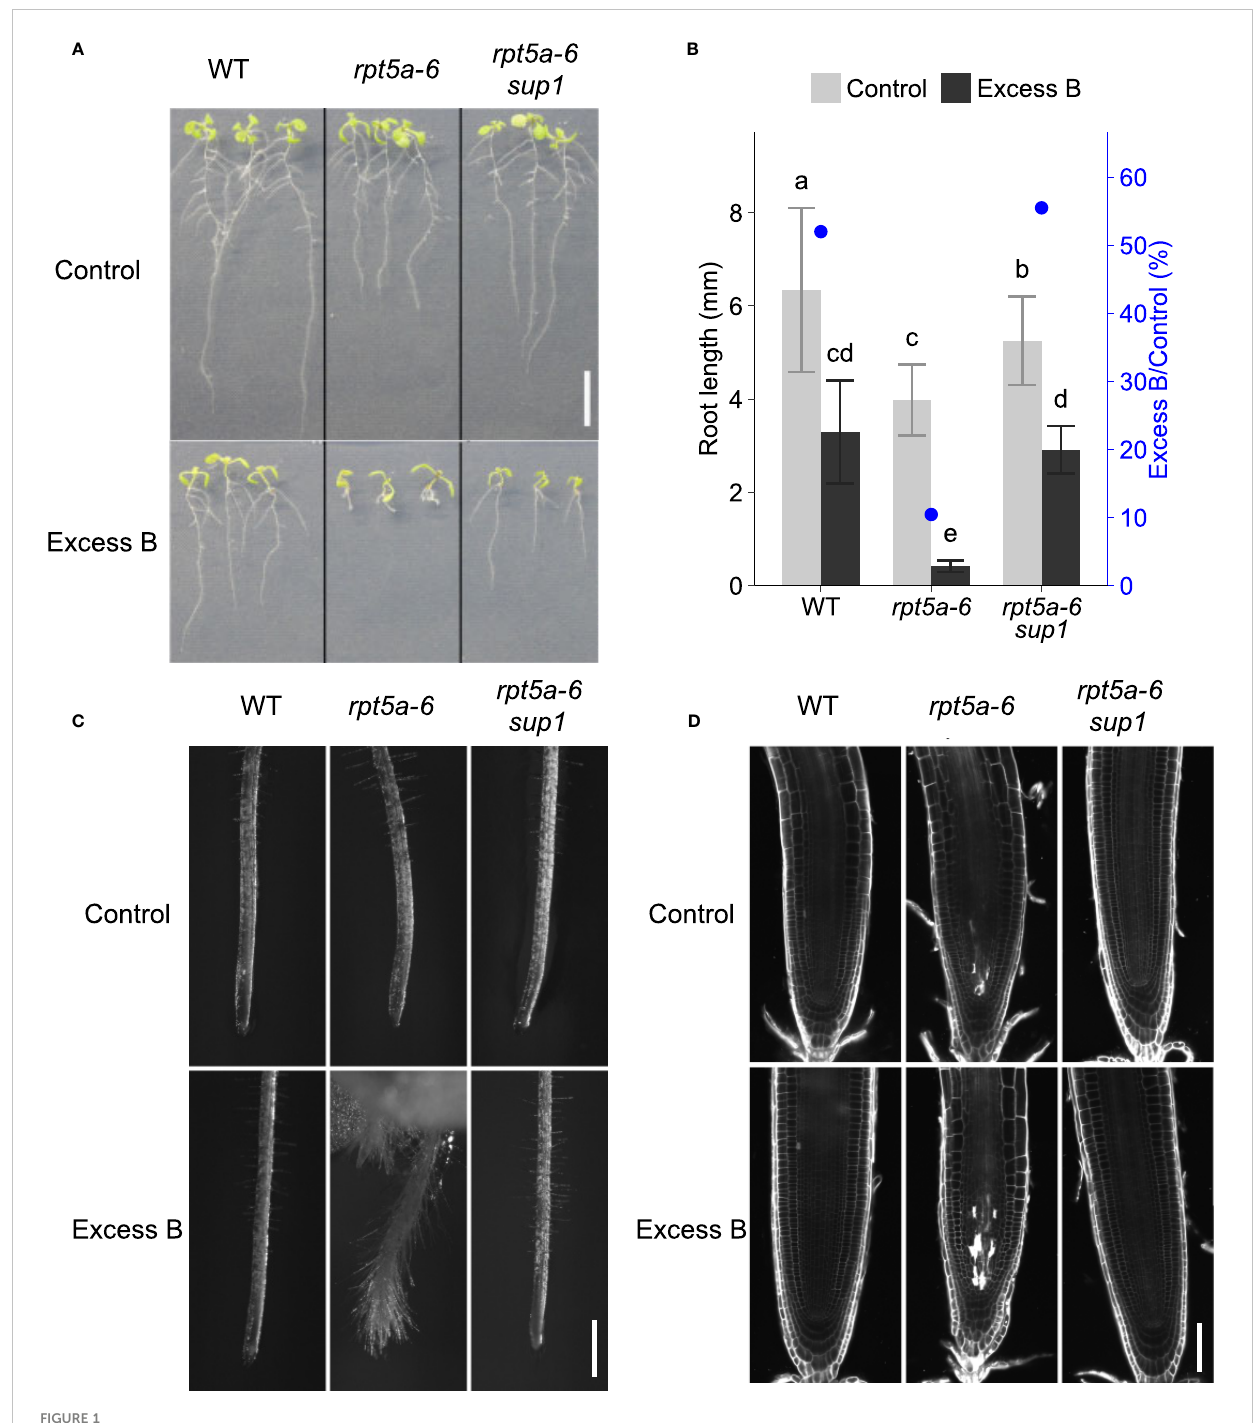
FIGURE 1 Phenotypes of the mutant in which excess boron sensitivity of rpt5a-6 is suppressed. Wild type, rpt5a-6 and its suppressor mutant rpt5a-6 sup1 were grown under excess boron (3 mM boric acid) or control (30 µM boric acid) conditions. (A) Ten-day-old seedlings. Bar, 1cm. (B) Primary root length of ten-day-old seedlings. Values are mean ± standard deviation of 12-23 individuals. Blue dots represent relative root length. Groups sharing the same letters are not signi fi cantly different at p < 0.05 by Tukey-Kramer ’ s test. (C) Primary root tip morphology of 11-day-old seedlings by stereomicroscopy. Bar, 500 µm. (D) Confocal microscopy of root meristems. Six-day-old seedlings grown under the control condition were treated with control or excess boron conditions for 40 hours. Cell walls and dead cells were visualized with propidium iodide. Bar, 50